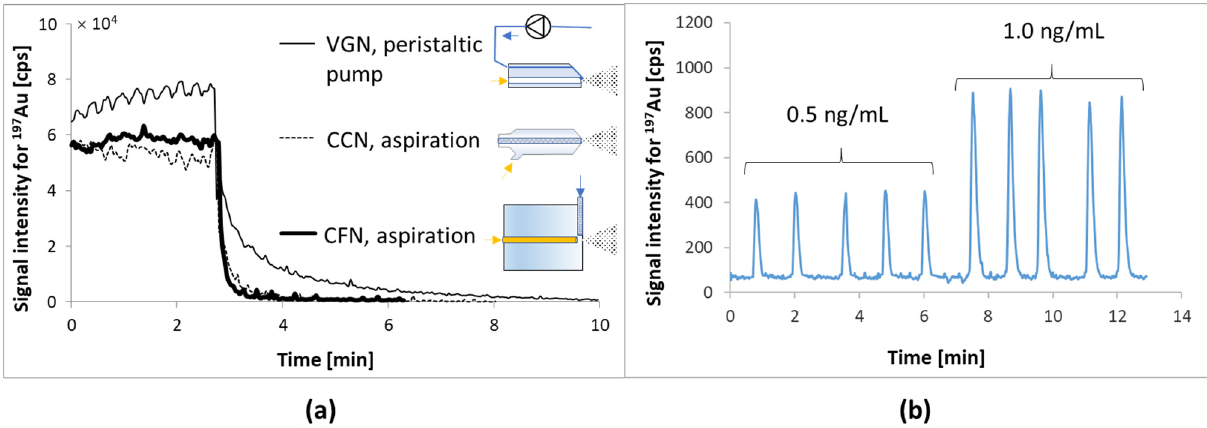
Figure 3. ( a ) The effectiveness of the sample introduction system rinsing with 2% hydrochloric acid solution after the introduction of gold (10 ng/mL) standard solution. VGN—V-groove nebulizer, CCN—concentric nebulizer, CFN—cross- flow nebulizer. ( b ) Changes of the signal intensity for 197 Au during FIA injections of 0.5 and 1.0 ng/mL Au in a solution of lysate diluted in proportion 1:3 equal to 17 and 34 fg of Au per cell. A 50 µL sample injected by Rheodyne valve into 0.5 mL/min mobile phase transported via PEEK tube with ID 0.13 mm.